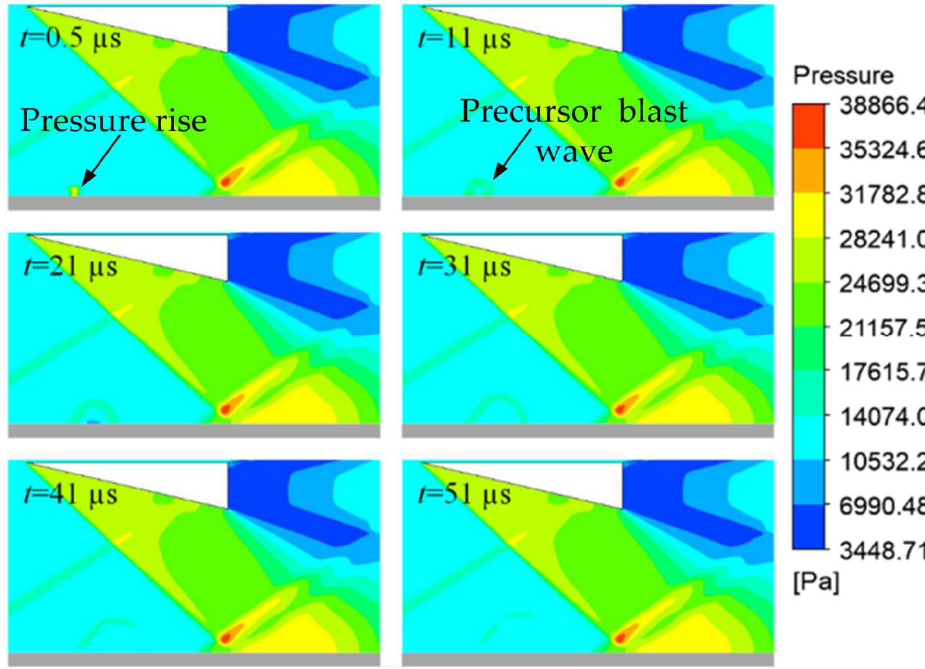
Figure 14. Pressure contour at z = 0 cross section at different moments.